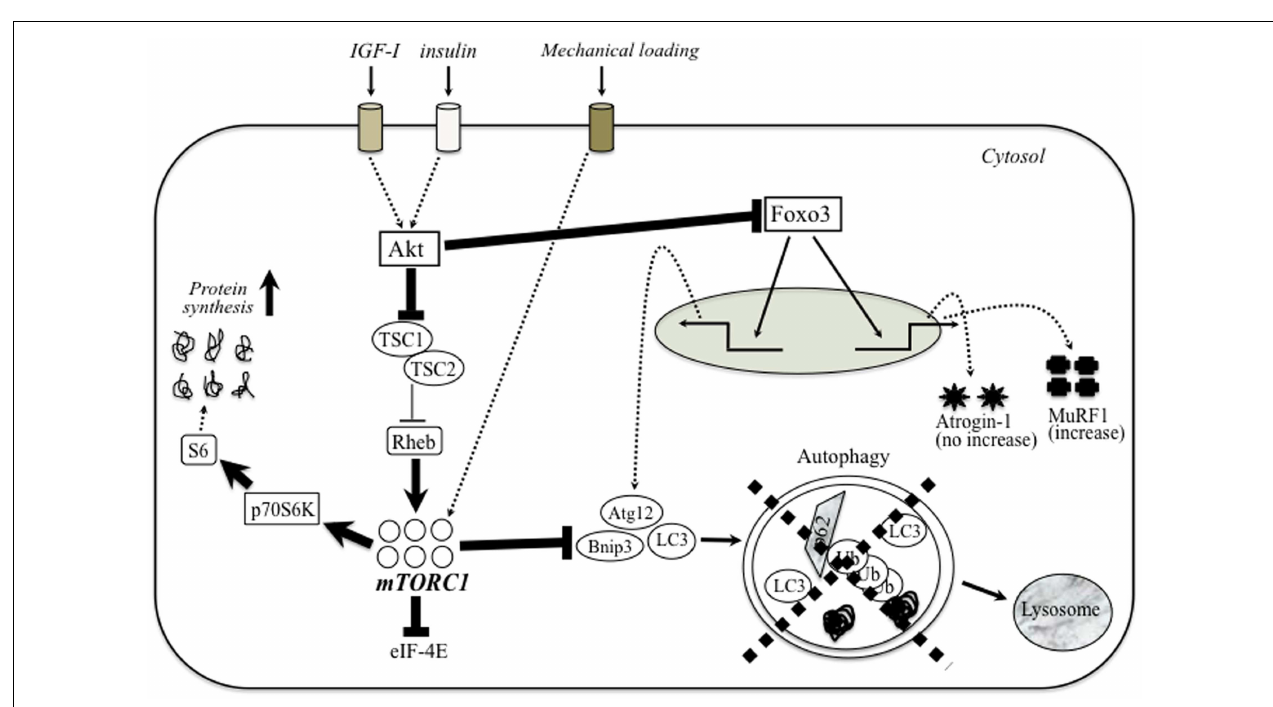
expression of autophagy-related genes (Bnip, LC3, and Atg12) and atrogene (atrogin-1 and MuRF-1). In dystrophic muscle, higher Akt potently blocks the inhibition of Rheb byTSC-1/TSC-2, and hyperactivate mTORC1. Unnecessary activated mTORC1 would extremely enhance protein synthesis and blocks autophagy-dependent signaling.Therefore, muscular dystrophy exhibits apparent defect of autophagic process similar to sarcopenic